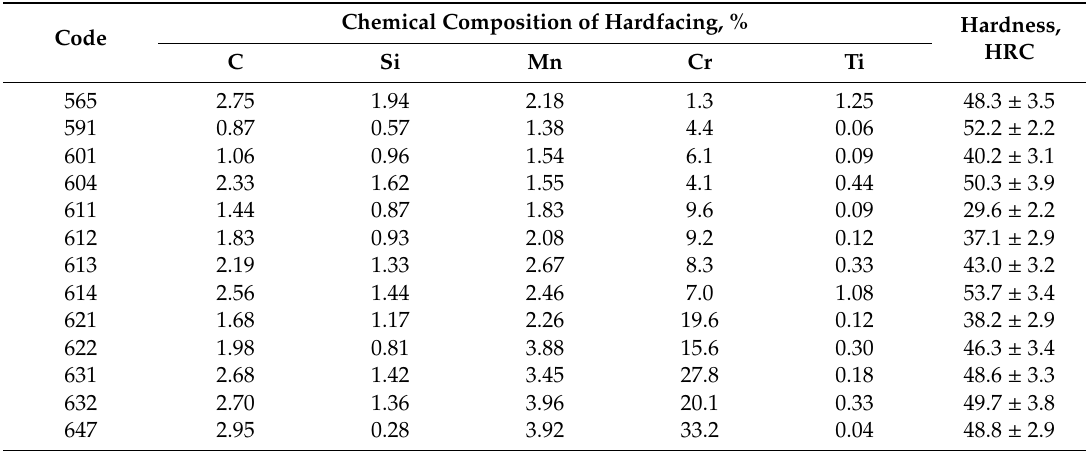
Chemical Composition of Hardfacing, % Hardness,